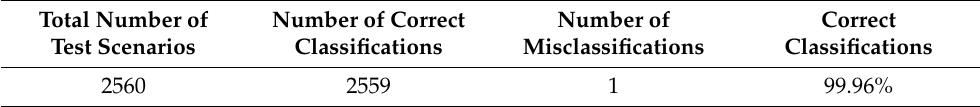
Table 7. Classification results for the generated random forest.